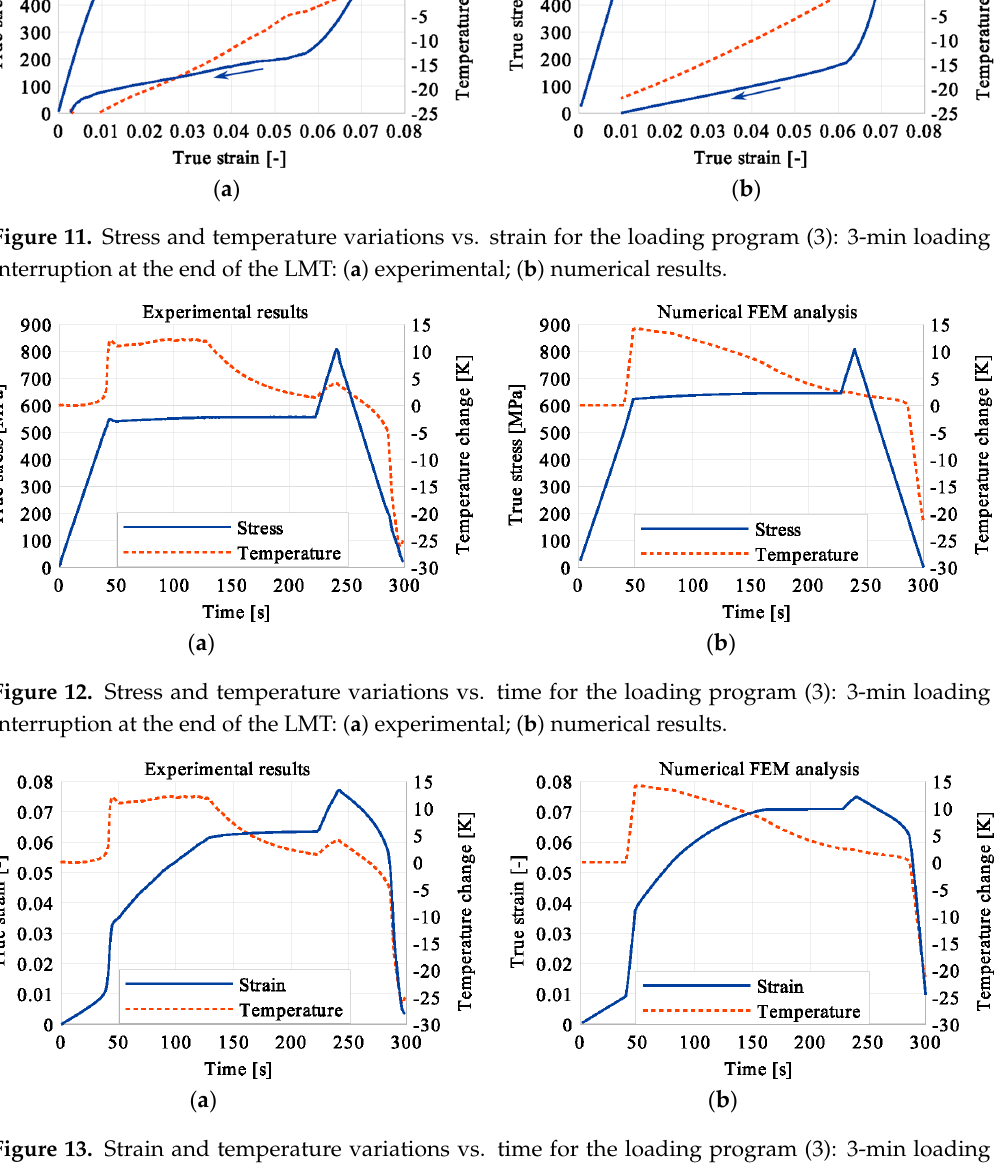
Figure 13. Strain and temperature variations vs. time for the loading program (3): 3-min loading interruption at the end of the LMT: ( a ) experimental; ( b ) numerical